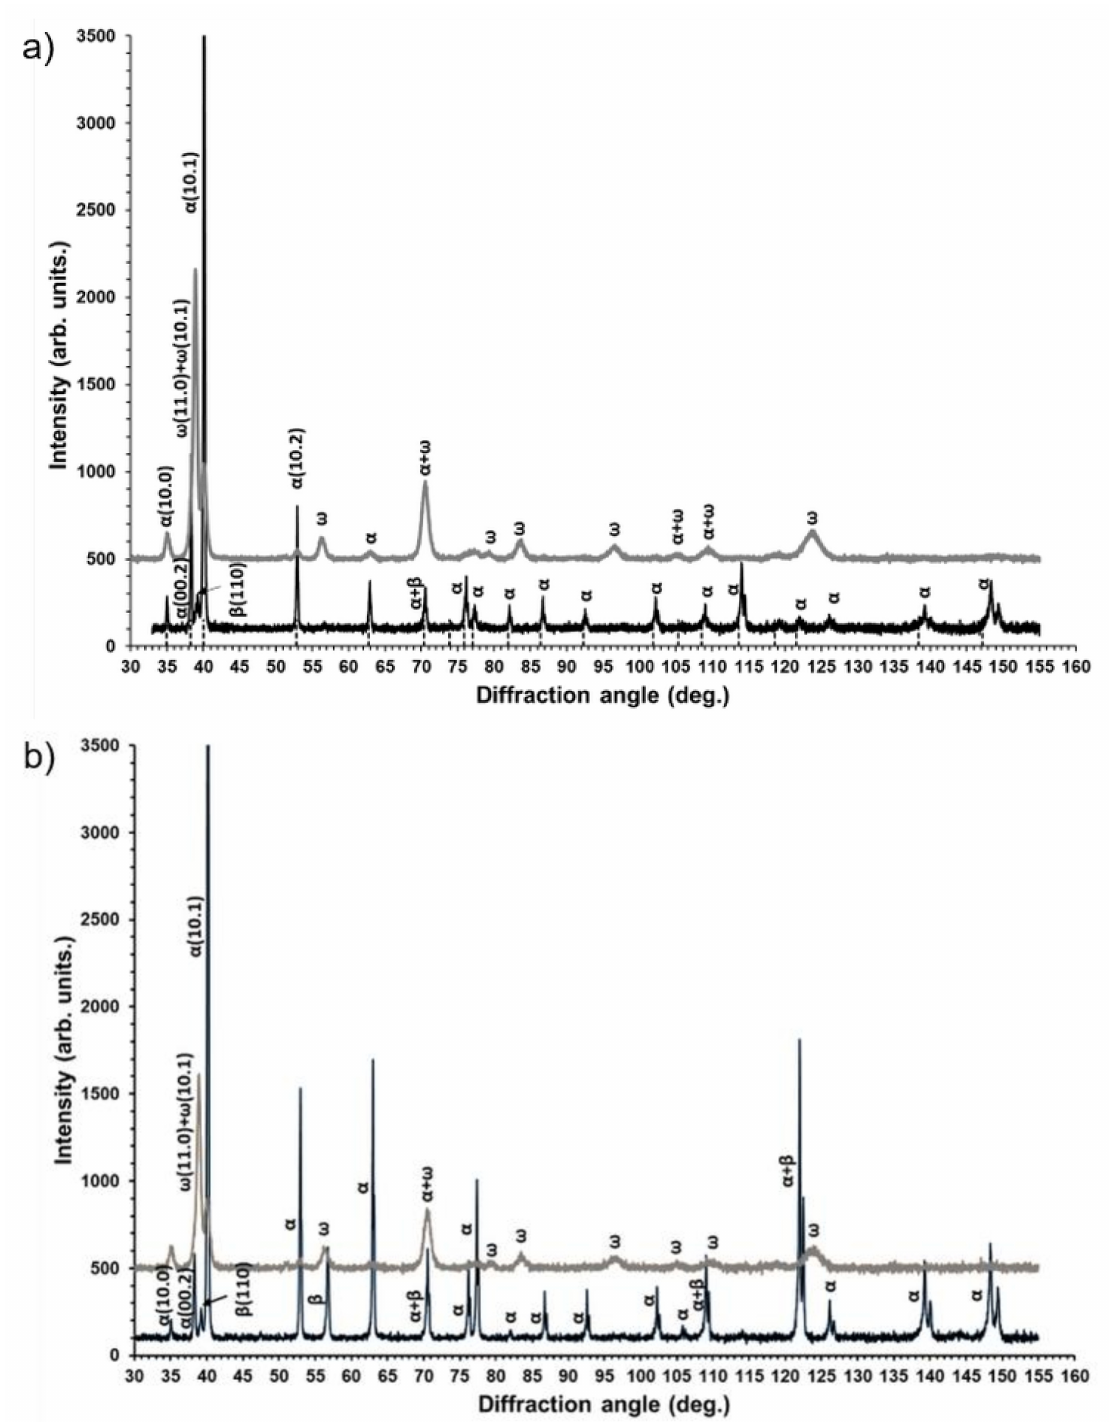
Figure 2. XRD patterns of the Ti–3wt.% Nb alloy before (black curves) and after (gray curves) HPT deformation for the samples pre-annealed at 450 ◦ C ( a ) and 600 ◦ C ( b